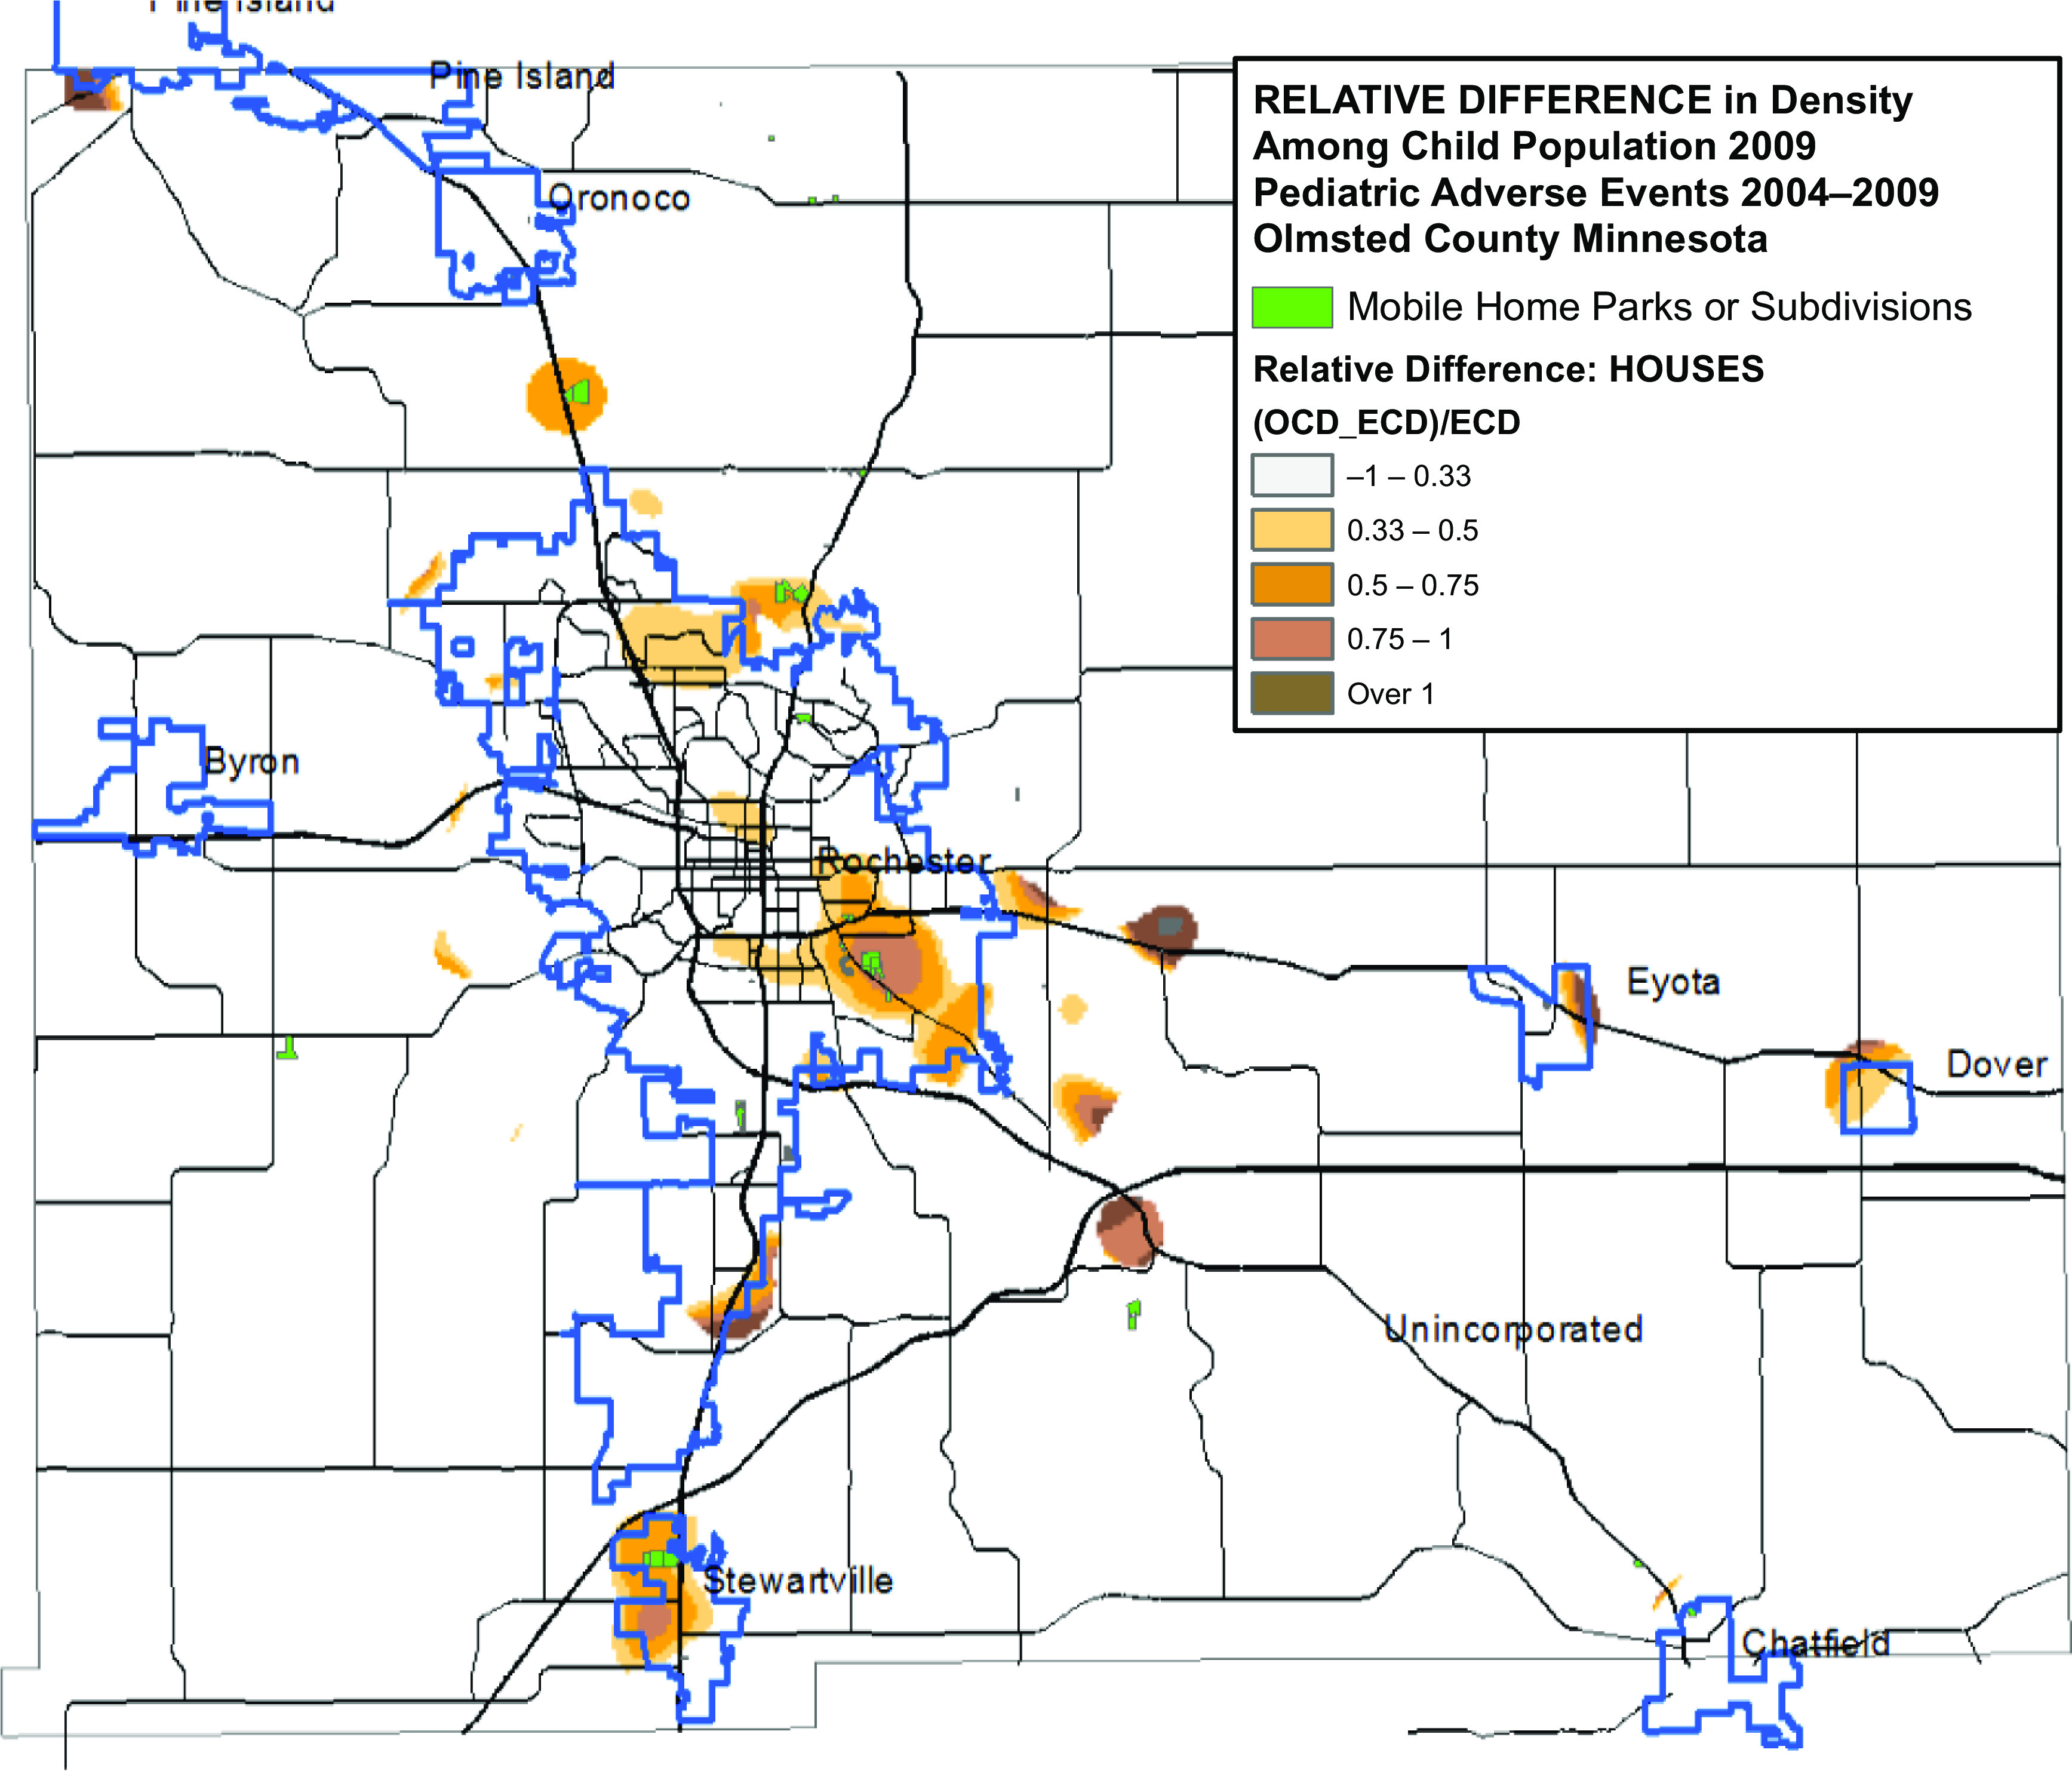
Unadjusted relative difference reflecting child population only.